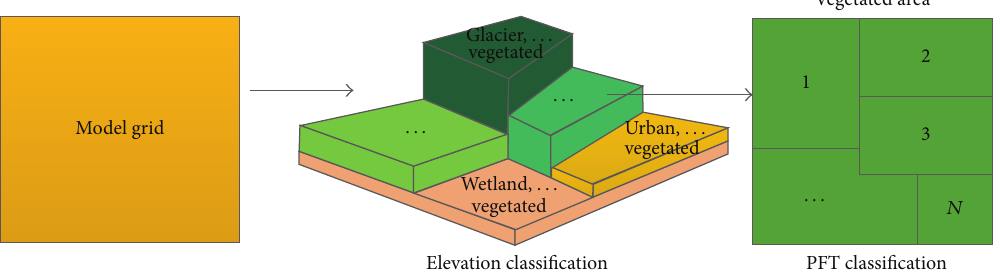
Figure 3: Schematic diagram of subgrid classification in SGC method. Modified from Ke et al.